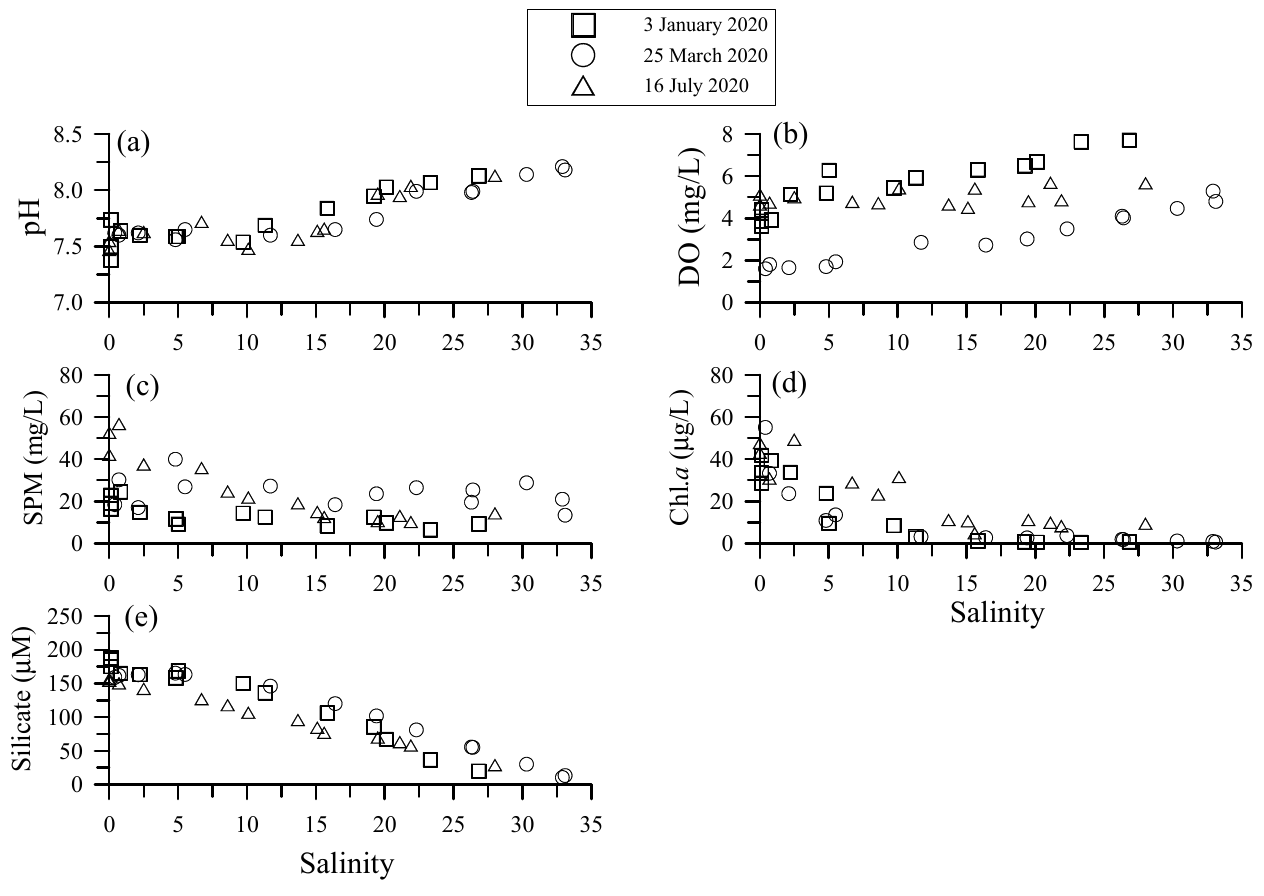
Figure 2. Scatter plots of ( a ) pH, ( b ) dissolved oxygen (DO), ( c ) suspended particulate matter (SPM), ( d ) Chl. a , and ( e ) dissolved silicate against salinity in the Danshuei River Estuary, northern Taiwan.